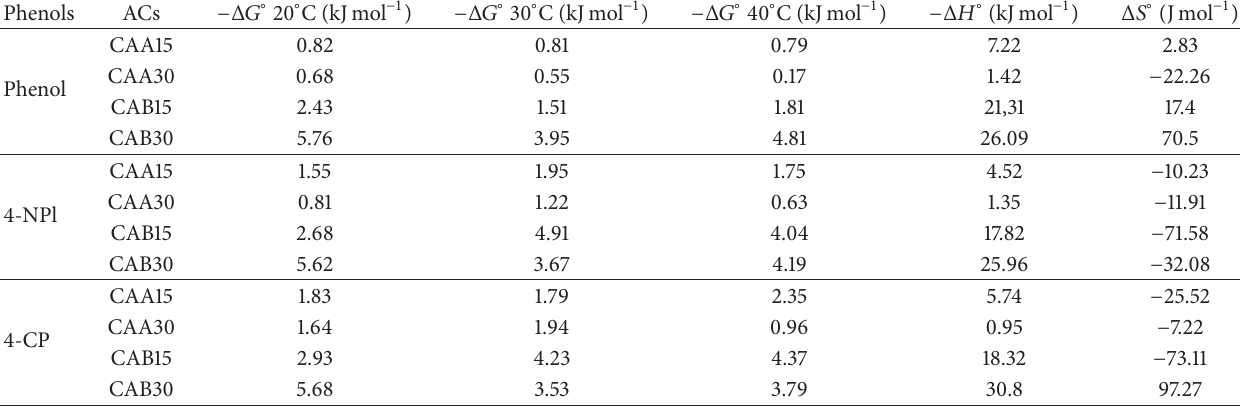
Table 3: Thermodynamic parameters for the adsorption of phenols on